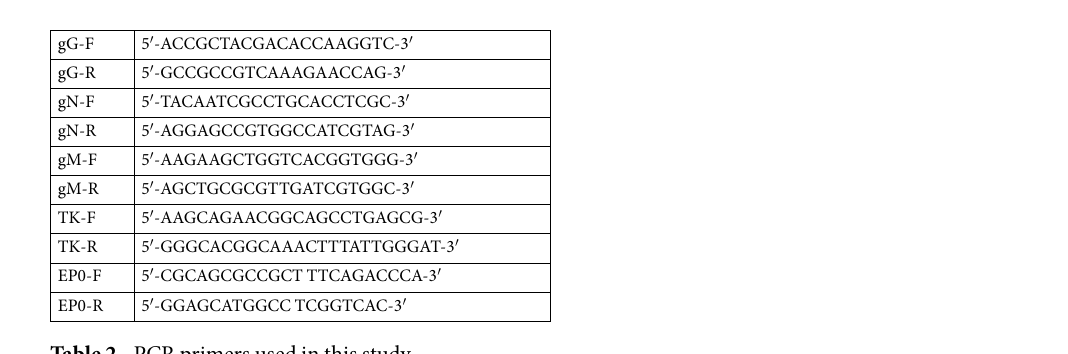
Table 2. PCR primers used in this